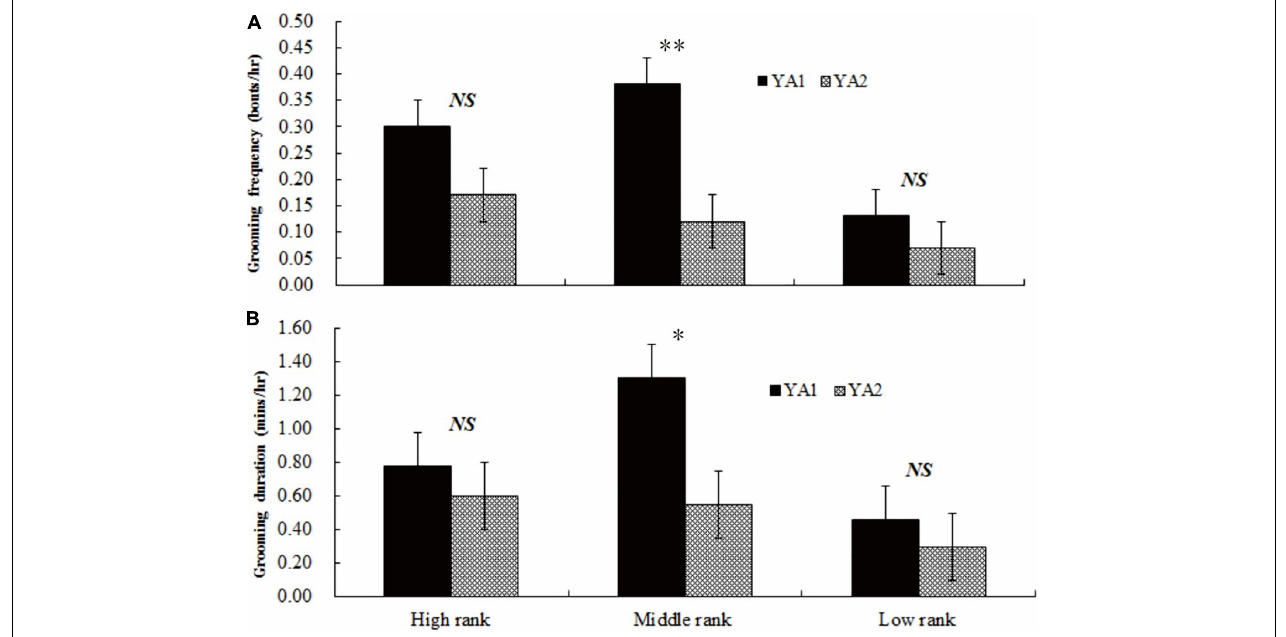
FIGURE 3 | Grooming frequency (A) and duration (B) of individuals of similar ranks between the two groups. High rank, middle rank, and low rank represents high-ranking, middle-ranking, and low-ranking females. NS, no significant difference; ∗ P < 0.05; ∗∗ P <